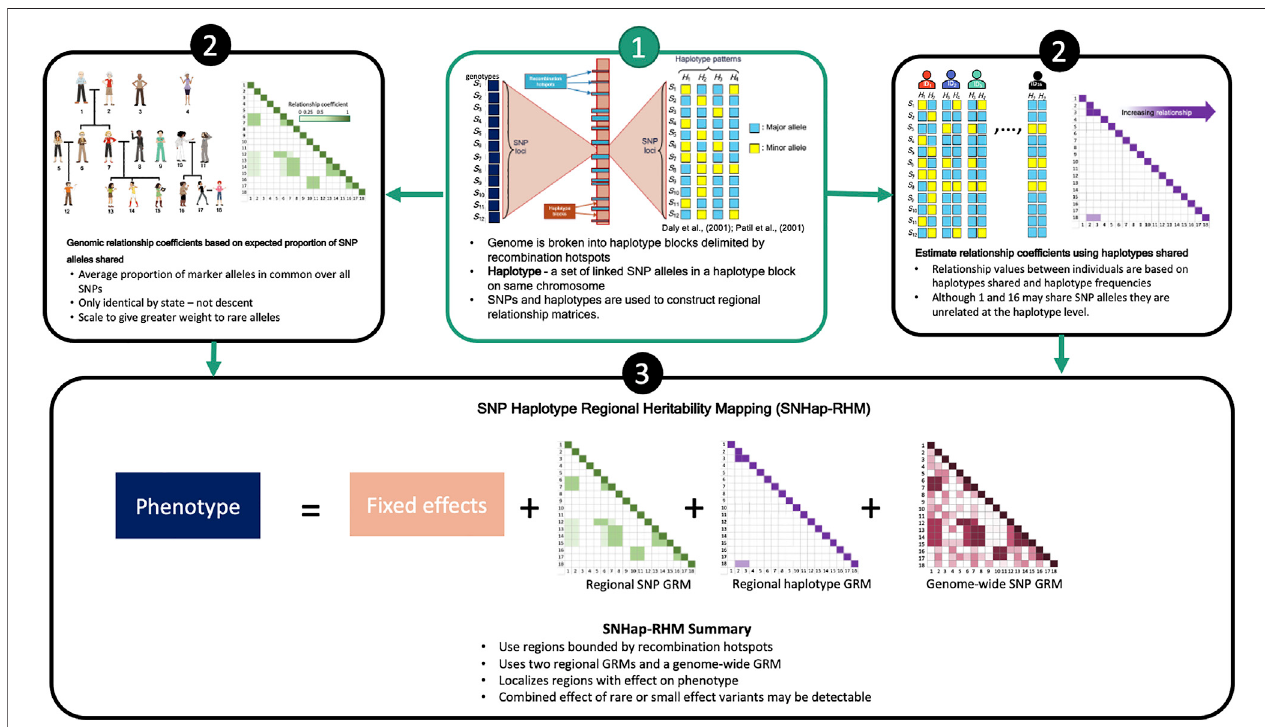
FIGURE 1 | A Schema outlying